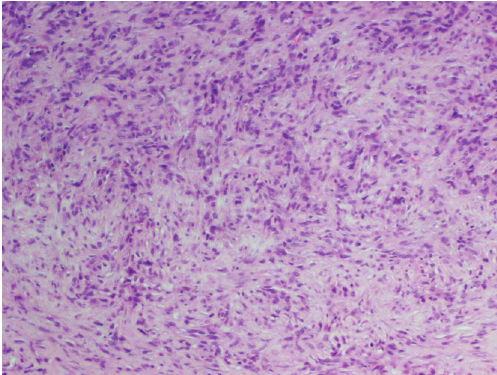
Figure 1: Low power showing a poorly demarcated tumour. Figure 2: Microscopic high power showing spindle cells with focal storiform arrangement and lymphocytic